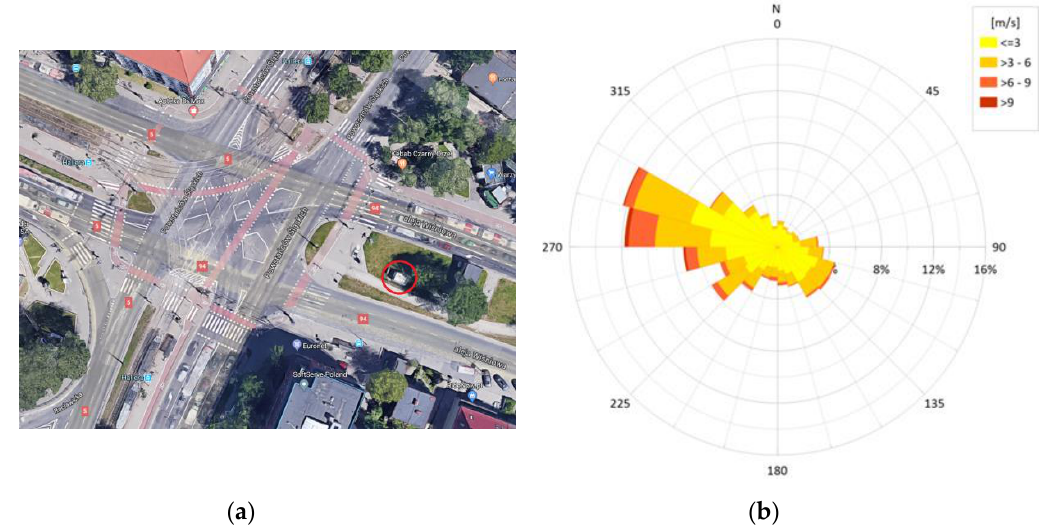
FigureA3. ( a )Theintersectionview(sourcewww.googlemaps.com); ( b )windroseforWrocław2015–2017. Figure A3. ( a ) The intersection view (source www.googlemaps.com); ( b ) wind rose for Wrocław